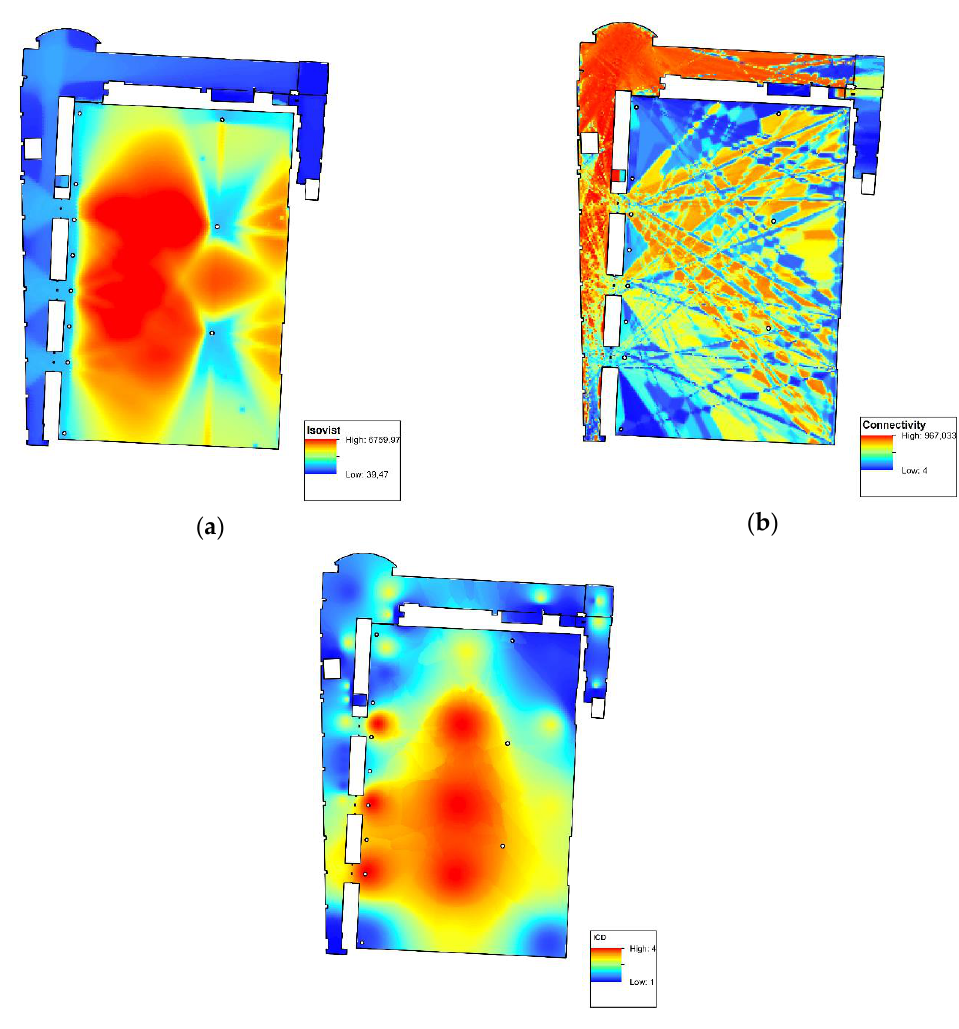
Figure 11. Legibility factors including ( a ) isovist, ( b ) connectivity, and ( c ) ICD.